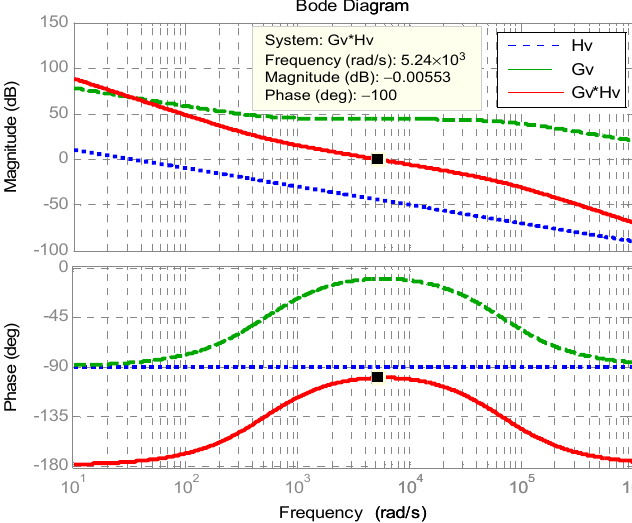
Figure 9. Bode plot of outer DC bus voltage control loop.